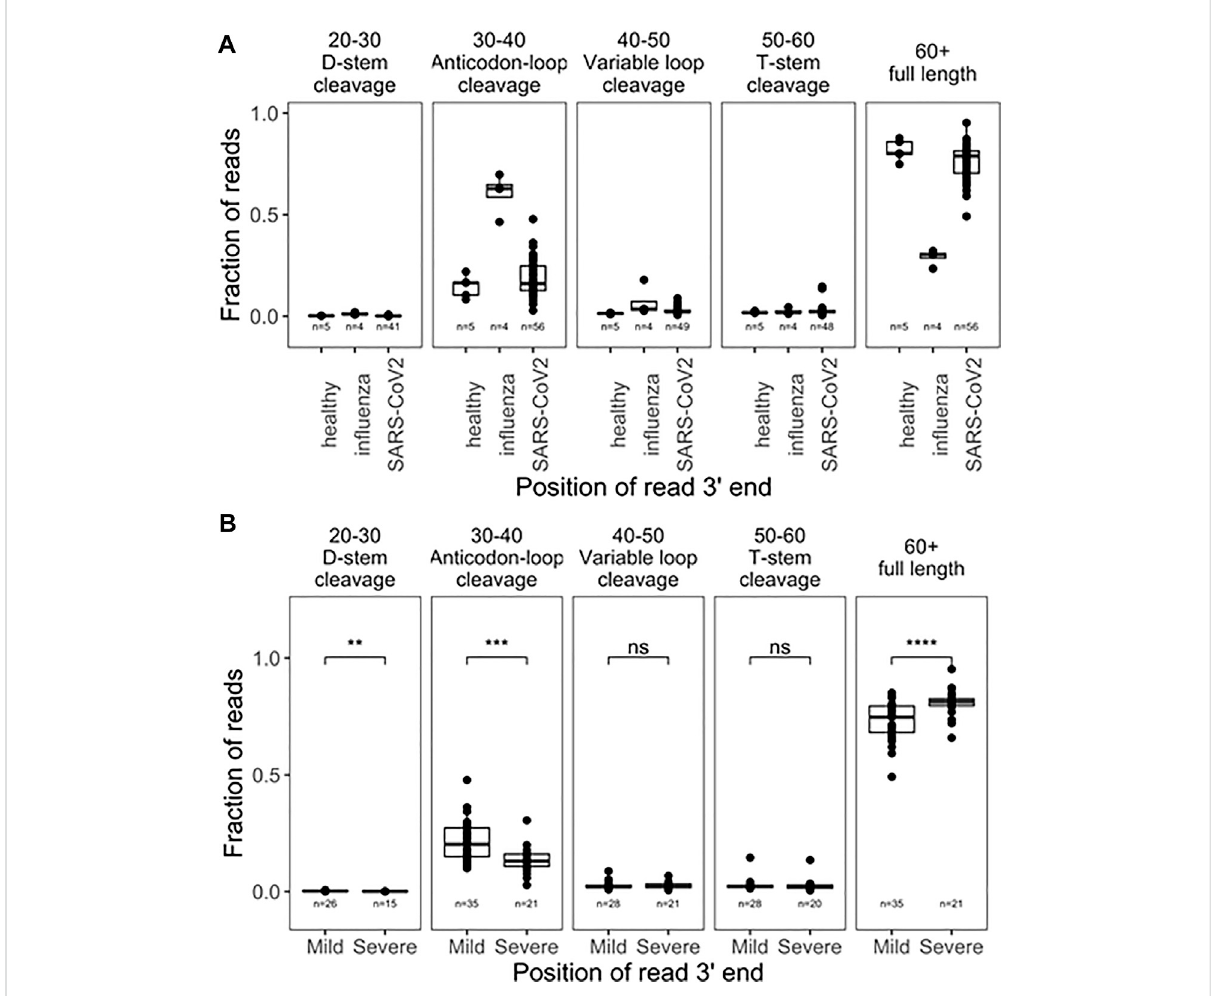
FIGURE 1 Global tRNAfragmentationpatternamongnasopharyngeal swab samples. (A) Fractionofreadsmapped todifferenttRNAfragments areshown foruninfectedcontrol( n =5),in fl uenzainfected( n =4),andSARS-CoV-2infected( n =56)individuals.AlltRNAspeciesarepooiedtogethertore fl ect global levels of tRNA fragmentation. (B) Comparison of global tRNA fragmentation between SARS-CoV-2 infected patients who go on to develope either mildorsevere COVID19symptoms. All tests are two-side-testwith thenumber ofsamples passing fi ltersindicated onthat plot, p -values: * < 0.05; ** < 10 − 2 ;*** < 10 − 3 ;**** < 10 −